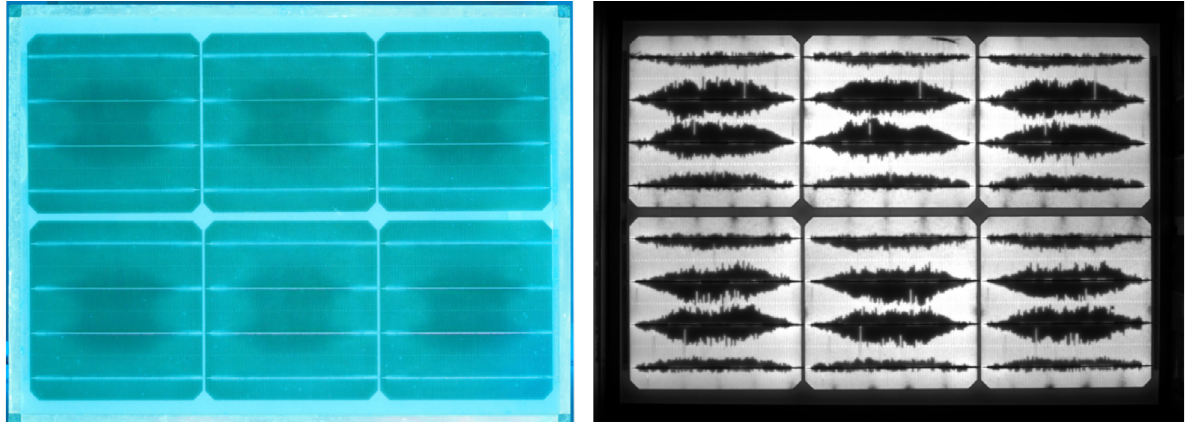
Fig. 4. Comparison of EL and UVF image after 3000h of Tropical 2 accelerated aging.